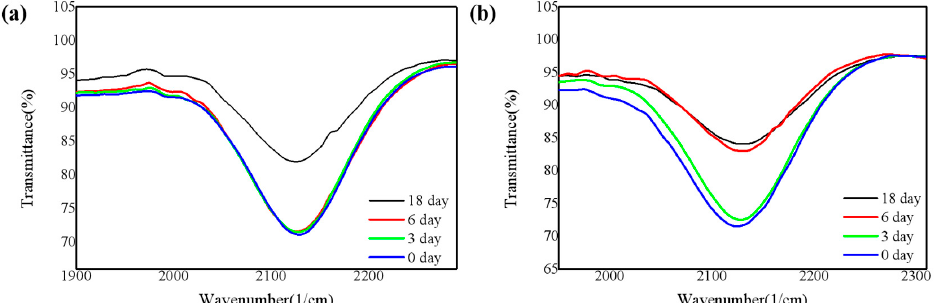
Figure 4. Infrared absorbance in the Si-H bond for four SiN x films ( a ) in the air and ( b ) under 85 °C/85% RH.